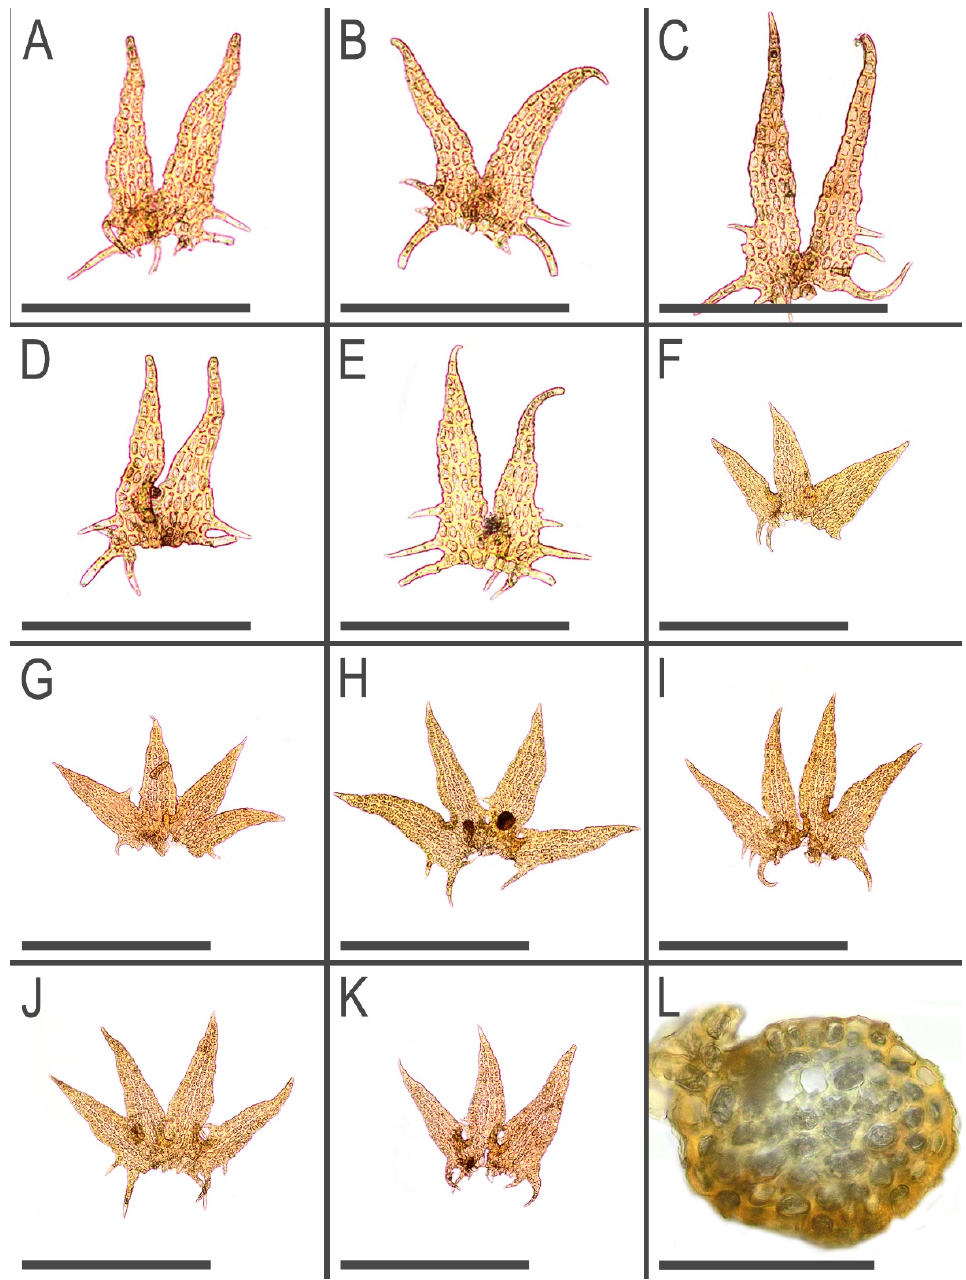
Figure 4. Tetralophozia sibirica Vilnet et Bakalin: A – E —underleaves; F – K —leaves; L —stem cross section; Scales: A – E —300 µm; F – K —500 µm; L —100 µm. All from holotype.